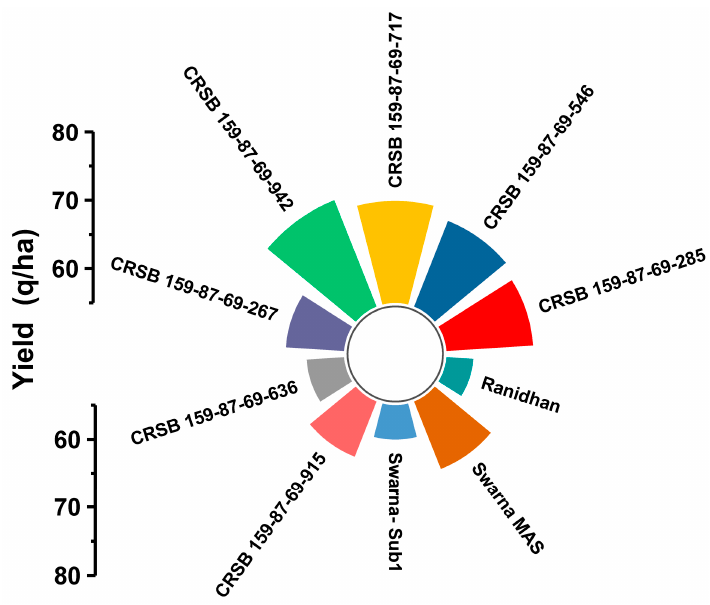
Figure 11. Diagrammatic representation of similarity of the pyramided and parental lines for grain yield/plot.